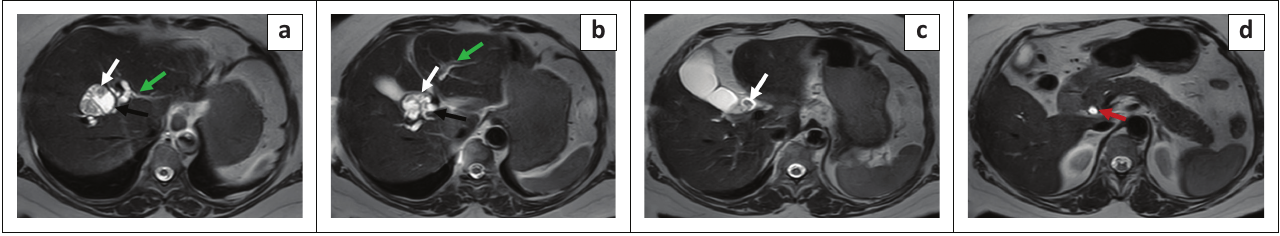
TSE, Turbo Spin Echo. FIGURE 1: T2W–TSE axial sections showing cystic dilatation (black arrow) at the primary confluence with internal, mural-based, frond-like hypointense contents (white arrow), extending to the common hepatic duct/CBD. Upstream dilated biliary radicles (green arrow) are observed with a mildly dilated CBD distally (red arrow).